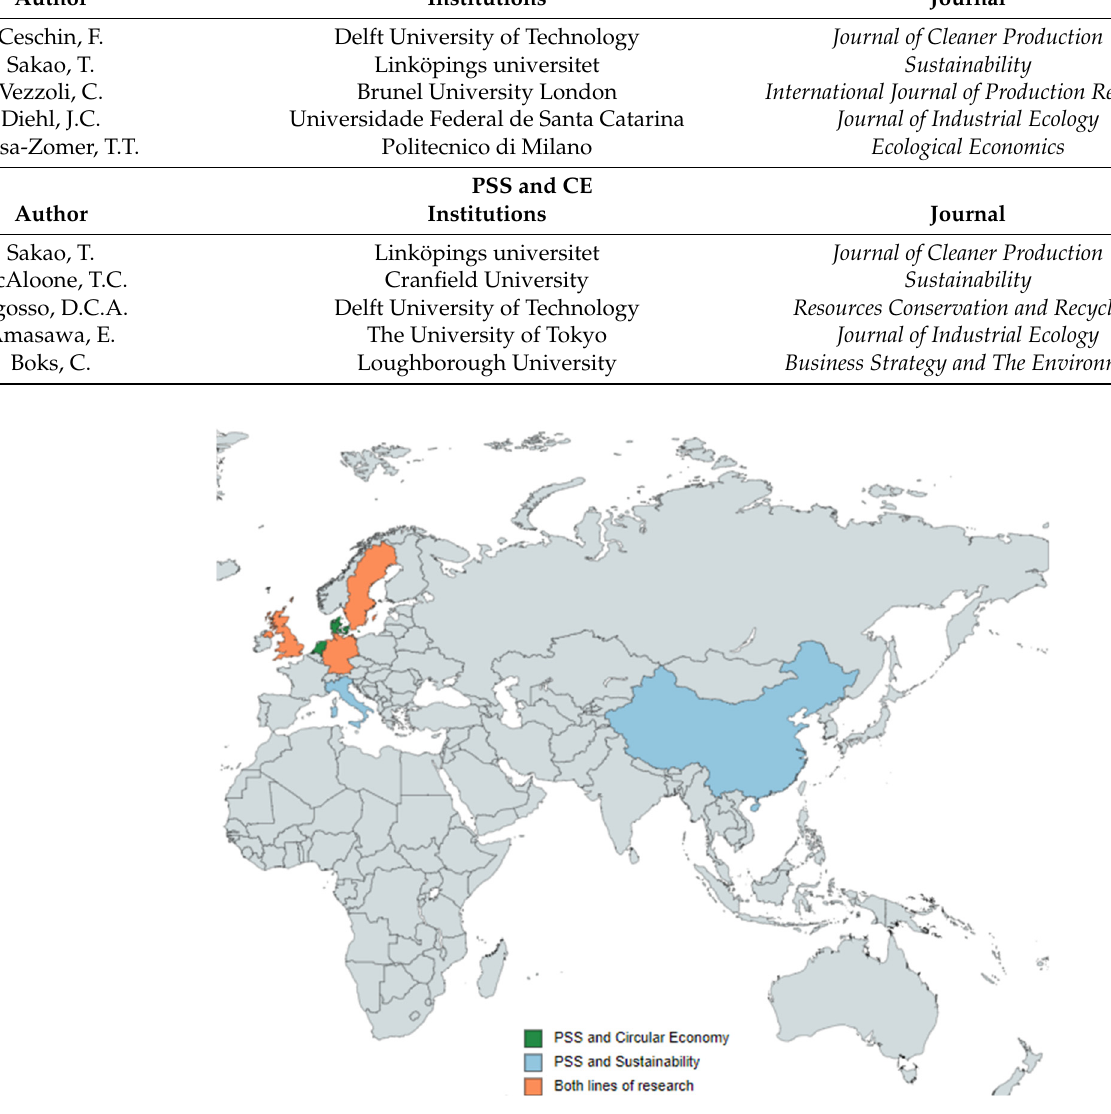
Figure 12. Most prolific countries for each line of research.